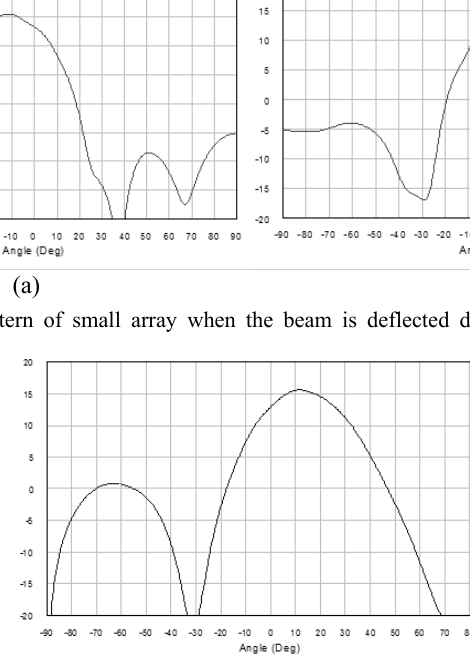
Fig. 5. Radiation pattern of small array when the beam is deflected in the azimuthal plane.